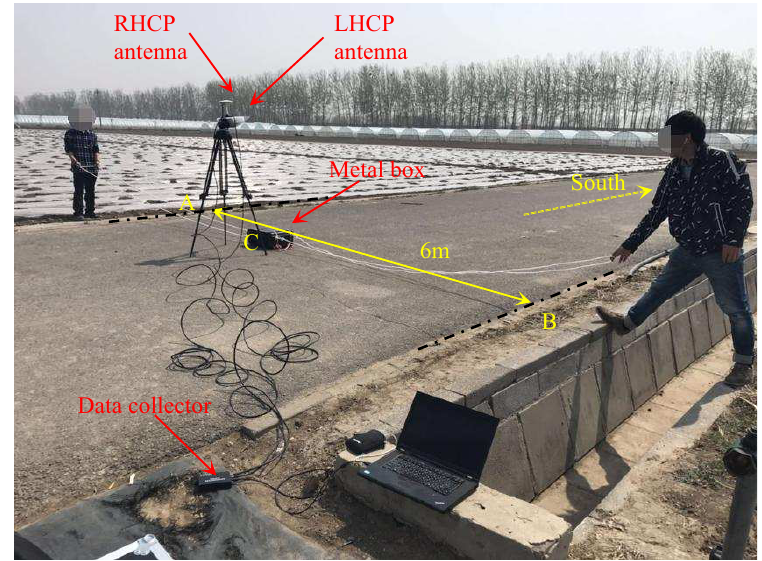
Figure 7. Measurement setup for ground target detection using BeiDou reflected signals in the second